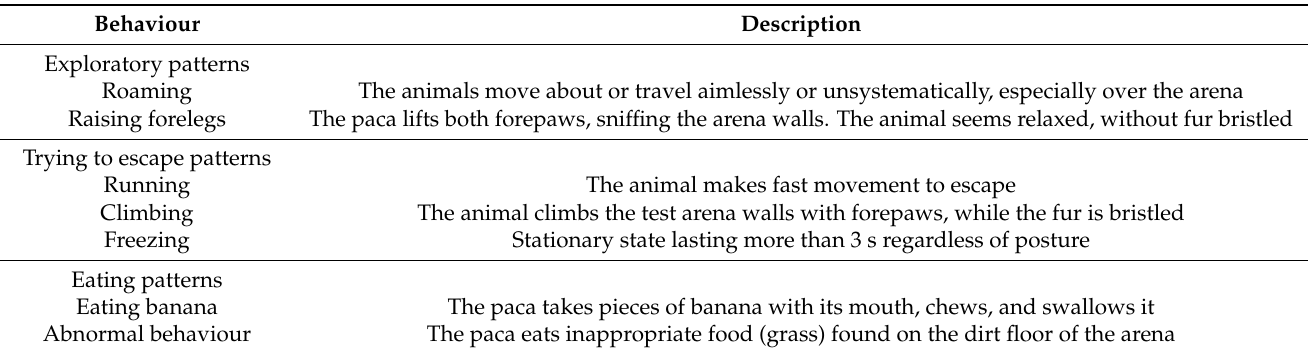
Table 2. Description of pacas’ behavioural responses during the defence test